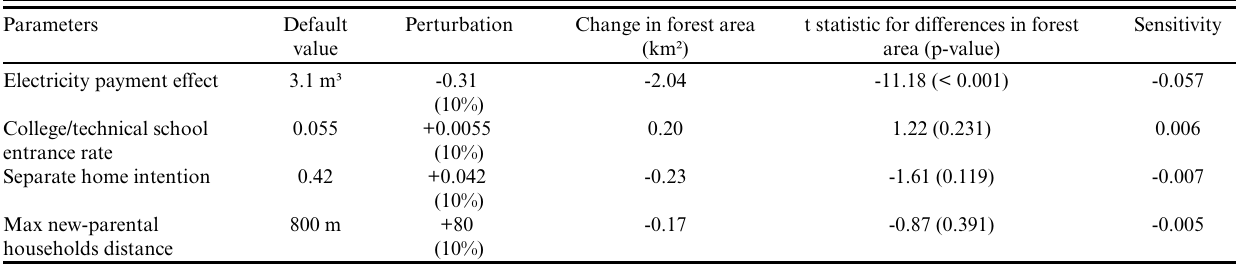
Table 6 . Sensitivity tests for selected model